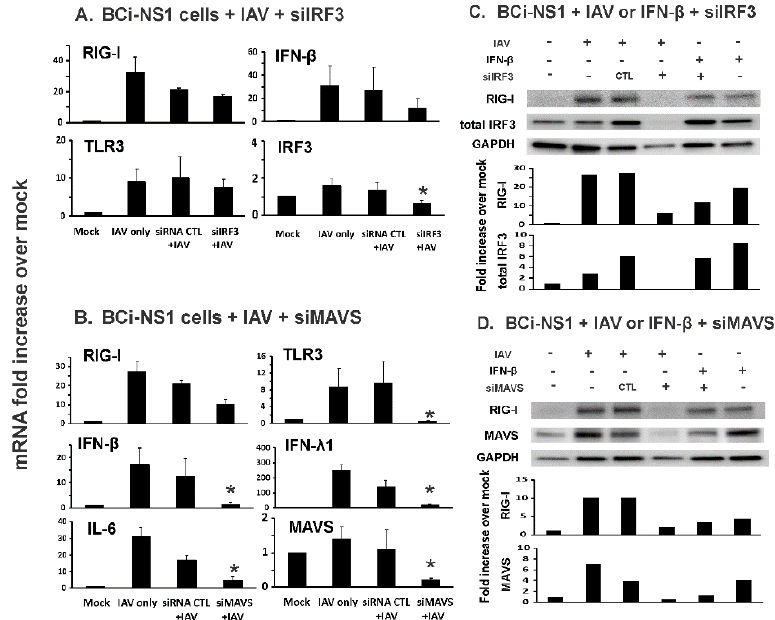
Figure 3. Knockdown of MAVS, but not IRF3, inhibited influenza-mediated RIG-I, TLR3 and cytokine mRNA induction in BCi-NS1.1 cells. The cells were first transfected with ( A and C ) IRF3 or ( B and D ) MAVS siRNA and cultured for 72 h and then infected with IAV PR8 (MOI = 0.2) for 24 h. Total RNA was extracted and mRNA expression was assessed by qRT-PCR ( A and B ). Data were expressed as the means ± SEM from three separate experiments. Statistical significance was determined by ANOVA. * denotes significant difference compared to data from the siRNA CTL+ IAV infected group, p < 0.05. ( C and D ) RIG-I, IRF3 and MAVS proteins in BCi-NS1.1 cells were detected by immunoblotting. The immunoblot shown is representative of three separate experiments, with quantitation of that result depicted below the image.